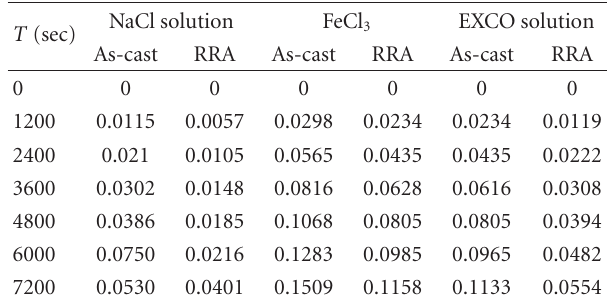
Table 7: Gravimetric corrosion rate (mm/yr) for the 2.02% Mg specimen.